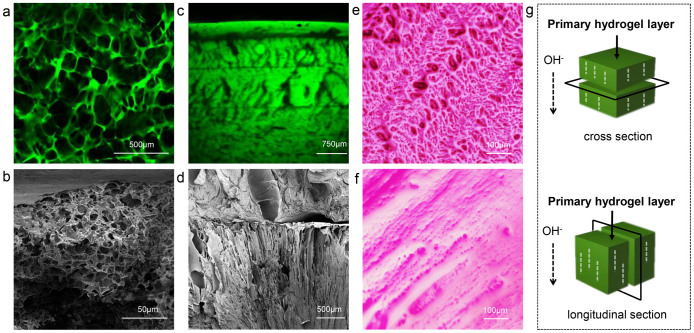
Morphology of hydrogel prepared by single-opening mold.(a)–(f) Micrographs of hydrogels: (a) CLSM image, c(CS) = 0.1 wt.%, cross section; (b) SEM image, c(CS) = 0.5 wt.%, longitudinal section; (c) CLSM images, c(CS) = 4.0 wt.%, longitudinal section; (d) SEM images, c(CS) = 3.0 wt.%, longitudinal section; (e) and (f) Fluorescence microscope images, bright field, colored by rhodamine for visibility, cross section and longitudinal section, respectively, c(CS) = 3.0 wt.%; (g) Schematic diagram of longitudinal and cross section of hydrogel, the longitudinal section is perpendicular to the primary hydrogel layer, while the cross section is parallel to it.